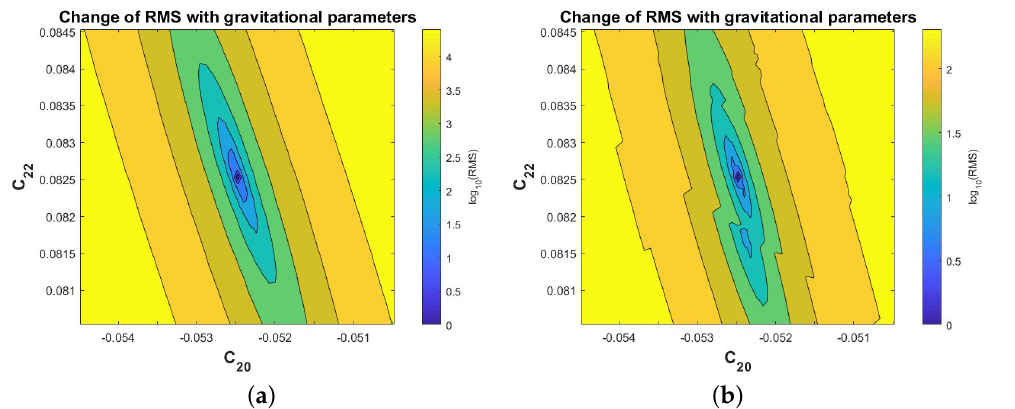
Figure 4. Contour map of the residual with respect to the gravity-field coefficients C 20 and C 22 (accuracy initial position). ( a ) Contour map of a 0.05(T) measurement interval. ( b ) Contour map of a 1(T) measurement